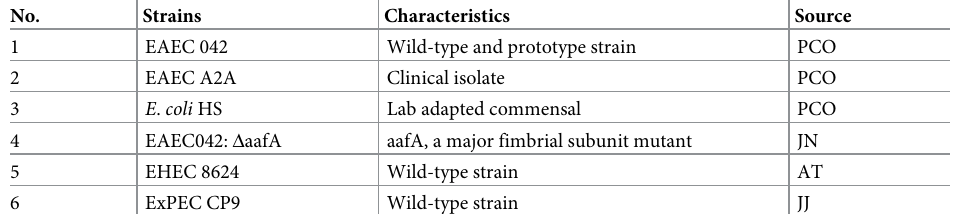
Table 1. Details of E . coli strains used in the study. Strains